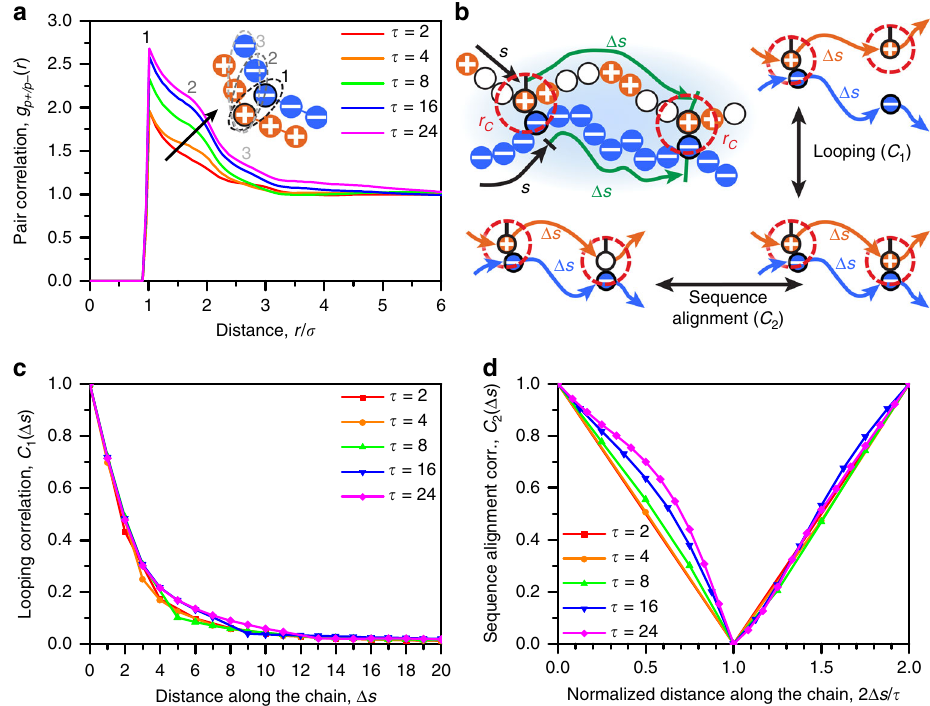
Fig. 5 Blocky sequences exhibit strong charge correlations due to sequence alignment at the same concentration. a Polycation/polyanion pair correlations for the dense phase at a single salt/polymer concentration denoted with an asterisk in Fig. 2a. When species concentrations are kept constant, there is a clear increase in polyelectrolyte correlations. b We use a set of pair correlations that capture the extent that two nearby chains interact; we follow their contour s and check for both spatial proximity within a cutoff r C and monomer charge. C 1 determines the probability that charged monomers separated along their respective contours Δ s loop. C 2 determines the probability that looped monomers are both charged. c Spatial looping correlations are measured by C 1 , which demonstrates negligible differences between different values of τ . However, there is a tendency for interacting polyelectrolytes to feature runs of charged monomers, whose sequence alignment is quanti fi ed by C 2 d . We attribute pair correlations in a to this